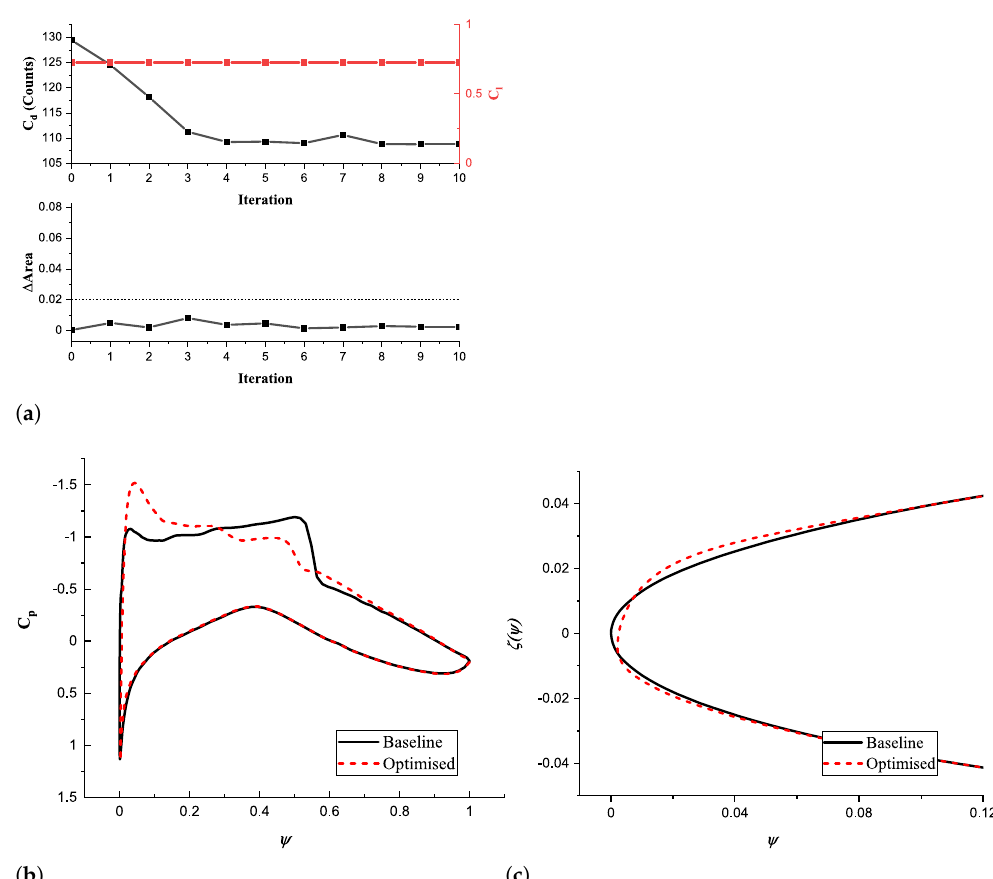
Figure 8. Comparison of results for the RAE 2822 optimization using a morphing leading edge. ( a ) Convergence history. ( b ) C p distribution. ( c ) Airfoil shape.